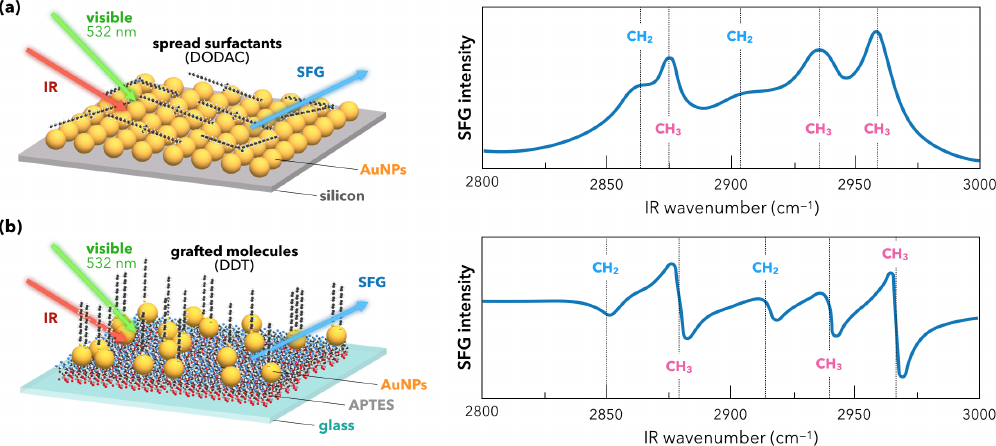
Figure 4. Sketch of the first reference SFG experiments performed on interfaces constituted of 15 nm diameter AuNPs synthesized by Turkevich method. ( a ) Scheme of the DODAC/AuNPs/Si interface (no grafting of AuNPs or DODAC molecules at any step). Each constituent is just deposited or spread, respectively. The corresponding SFG signal displays the five strong methyl and methylene peak-shaped vibration modes of the DODAC molecules (picture adapted from reference [31]). ( b ) Scheme of the DDT/AuNPs/Glass interface (grafting of AuNPs on glass through APTES and chemical functionalization of AuNPs by DDT molecules). The corresponding SFG signal displays the five weak methyl and methylene dip-shaped vibration modes of the DDT molecules (picture adapted from reference